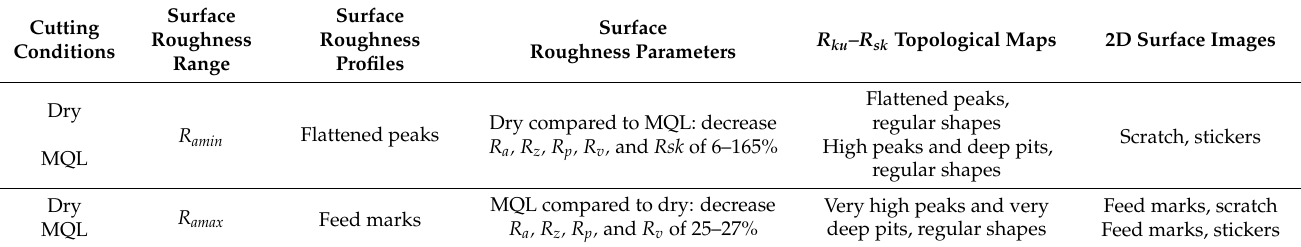
Figure 4. The 2D topographies of Ti6Al4V titanium alloy surface after finish turning. Table 3. Summary of Surface Topography Results of Samples with R amin and R amax of Ti6Al4V Alloy after Finish Turning under Ecological Cutting Conditions.